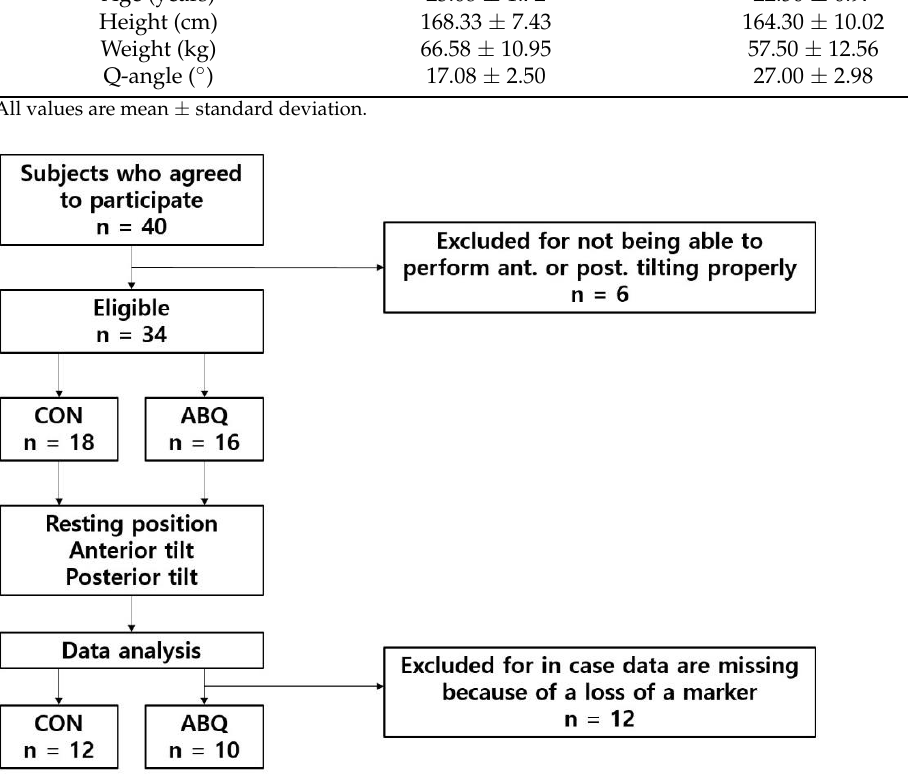
Figure 1. Flow chart of recruitment.